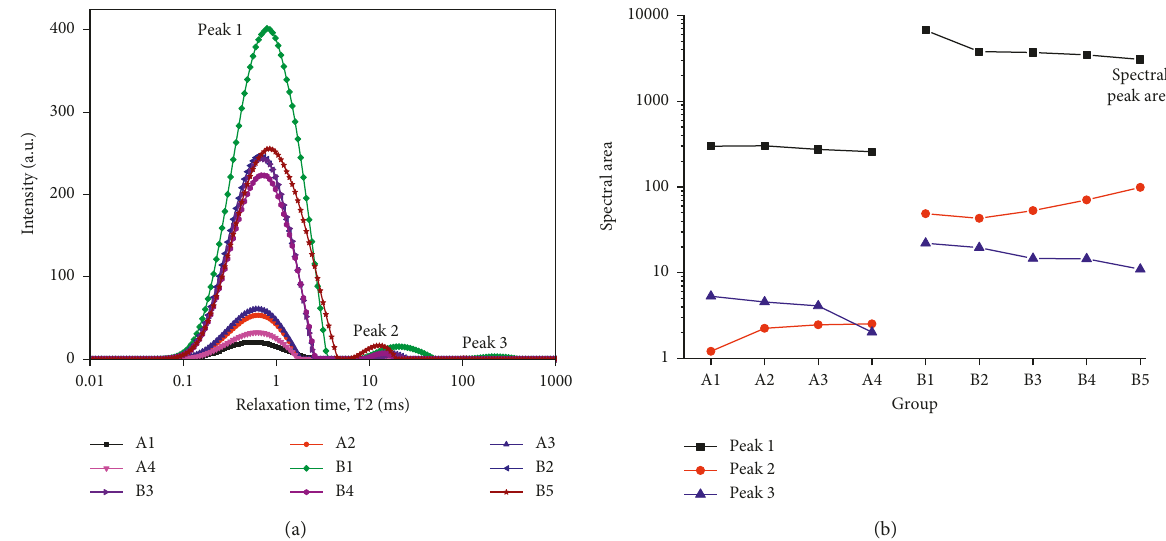
Figure 10: (a) NMR T2 spectrum distribution and (b) areas of Peak 1, Peak 2, and Peak 3 after the curing time of